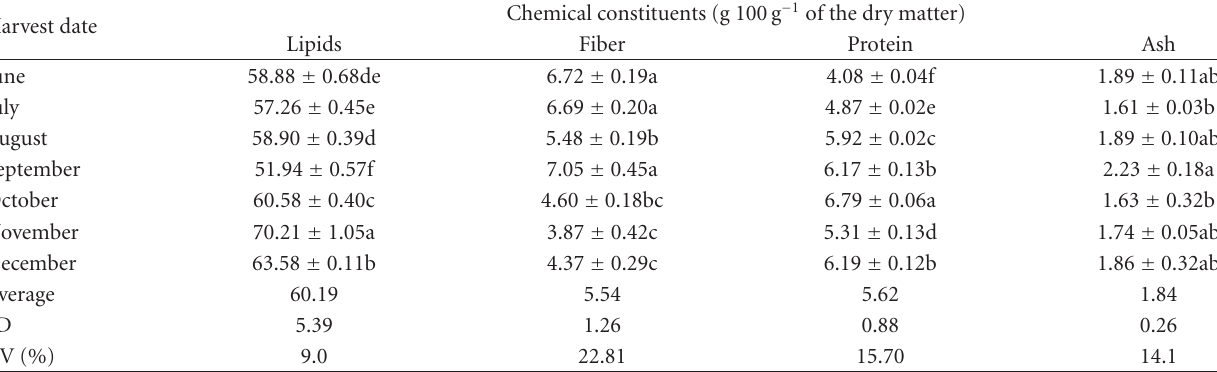
Table 3: Chemical composition of the patau ´ a ( Oenocarpus bataua Mart.) fruits harvested in the Adolpho Ducke Forest Reserve, in Manaus, Amazonas,